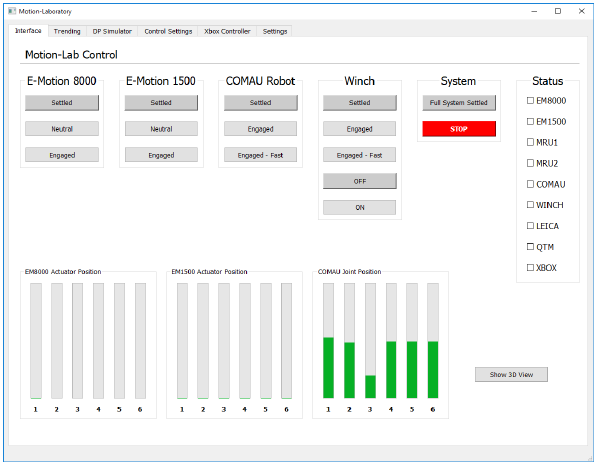
Figure 10: Main interface of the Motion-Lab